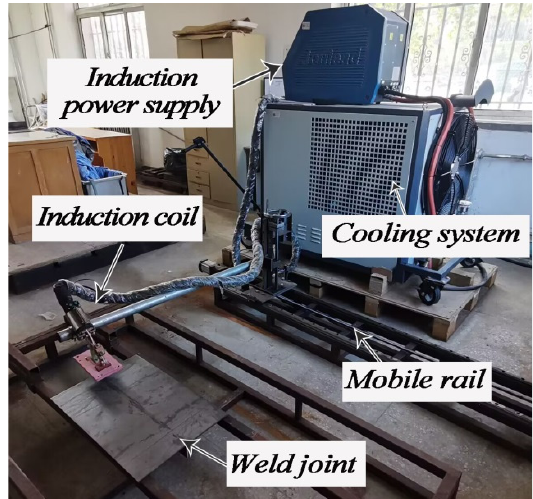
Figure 6. The experimental process for induction heating.